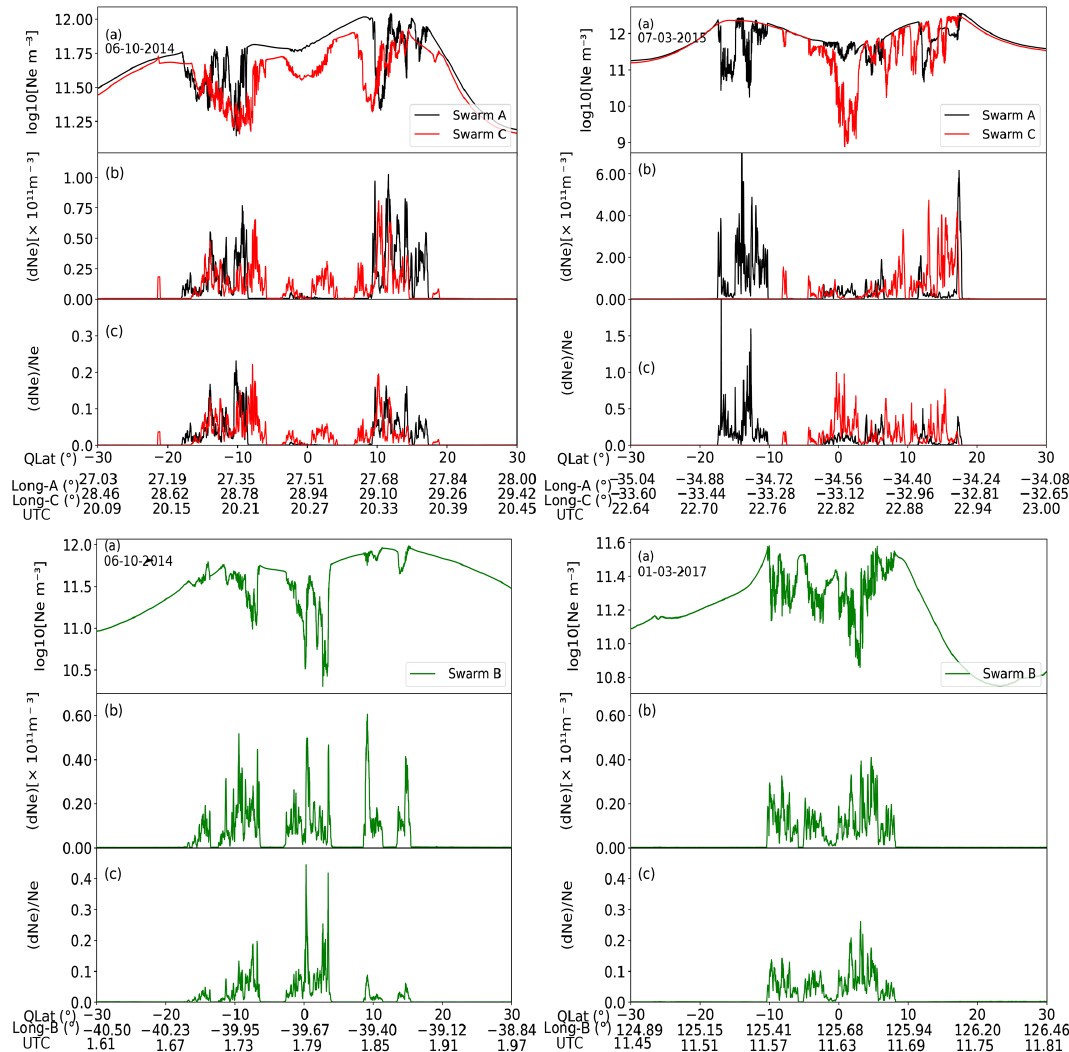
Figure 2. Irregularity structures observed by Swarm A, C and B. Panels (a) to (c) represent electron density ( N e ) variation at 16Hz in loga- rithmic scale, absolute ( dN e ) and relative ( dN e /N e ) electron density perturbations, respectively, as functions of QLat, geographic longitude (GLong) and universal time